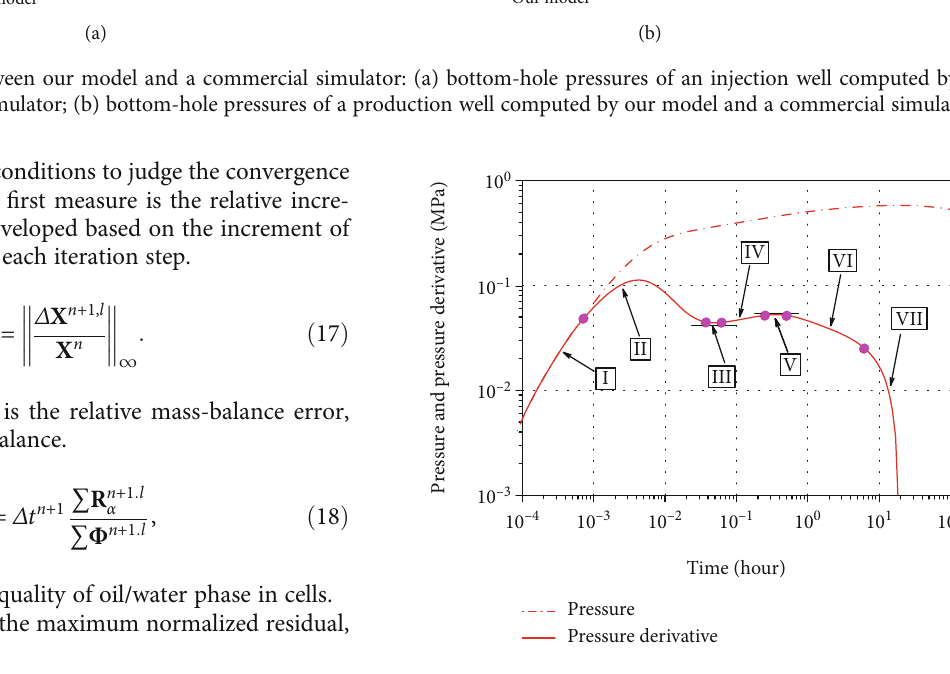
Figure 9: Type curve and fl ow regimes of our model. I is the fl ow regime of wellbore storage, II is the fl ow regime of wellbore damage, III is the fi rst radial fl ow regime, IV is the fl ow regime of transitional zone caused by water injection before shut-in, V is the second radial fl ow regime, VI is the transitional fl ow regime of formation damage, and VII is the fl ow regime of interference from two adjacent